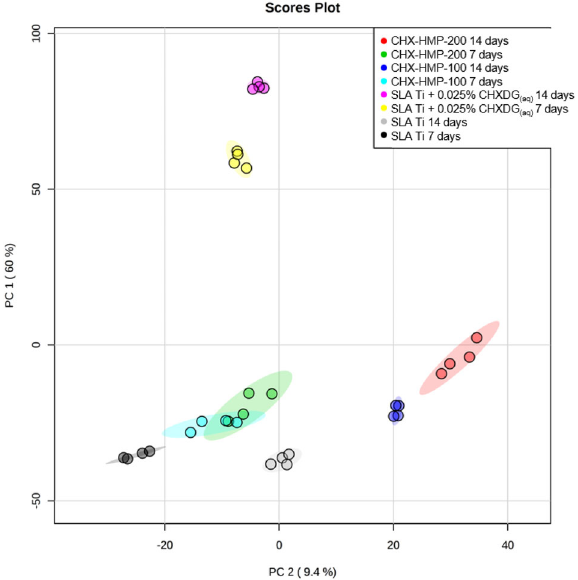
Fig. 6 Combined PCA plot for data on all surface types at both 7 and 14 days. Data has been log transformed to facilitate presentation, after normalisation to SLA Ti at 7 days ( n = 1). Filled circles represent single specimens, shaded area represents region of 95% con fi